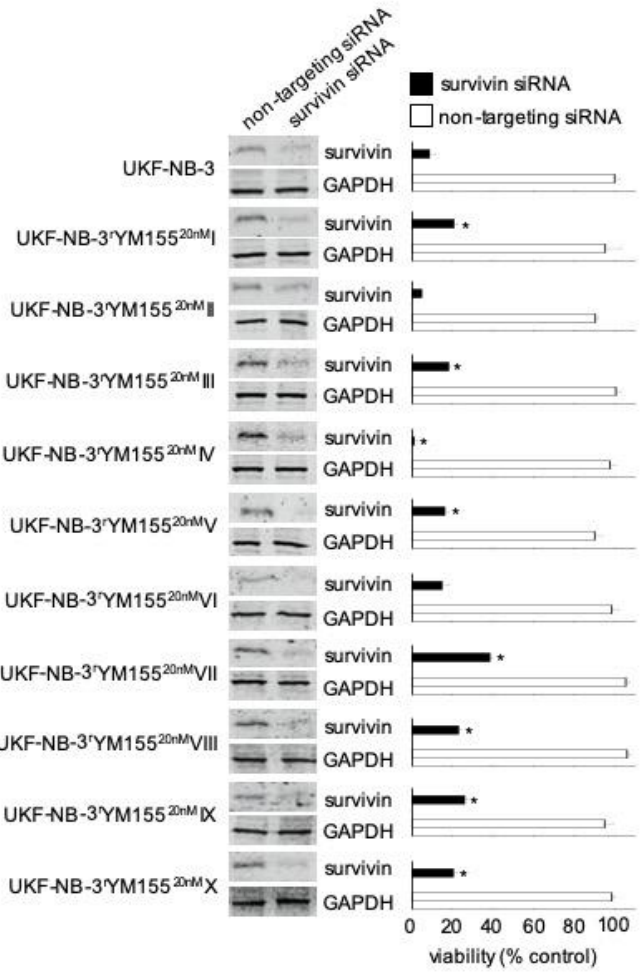
Figure 4. Effects of siRNA-mediated BIRC5/survivin depletion on the viability of UKF-NB-3 and its YM155-adapted sublines. Western blots confirm reduced survivin levels 48 h post-transfection. Viability of cells transduced with siRNA directed against BIRC5/survivin or non-targeting siRNA was determined relative to untreated control cells 168 h post transfection by MTT assay. The cell lines displayed varying levels of sensitivity to survivin depletion. * p < 0.05 relative to untreated cells. Uncropped blots are shown in Figure S4.